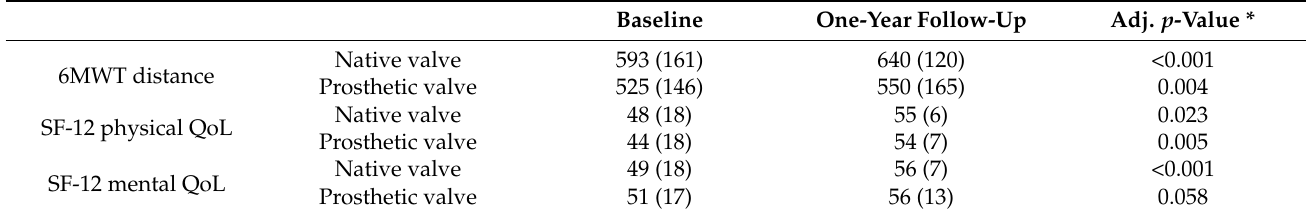
Table 2. Longitudinal changes from baseline to 1-year follow-up.